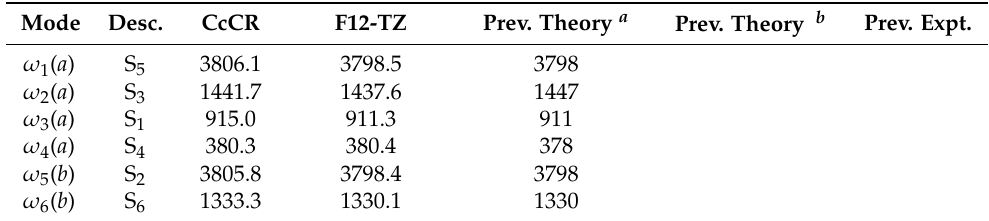
Table 2. Vibrational frequencies (cm − 1 ), and IR intensities (km/mol) given in parentheses for HOOH compared to the previous theory and gas-phase